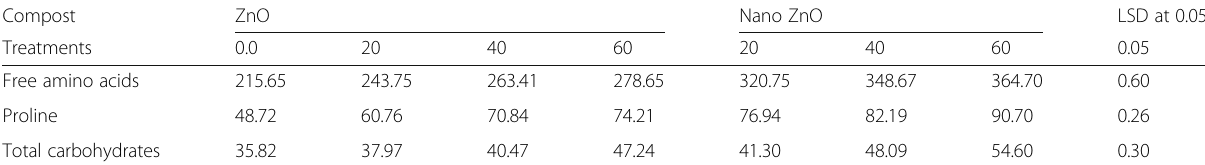
Table 12 Effect of ZnO and nano ZnO levels (0, 20, 40, and 60 mg/l) on free amino acids, proline (mg/100 g dry wt), and total carbohydrate percentage of flax leaves under sandy soil Compost ZnO